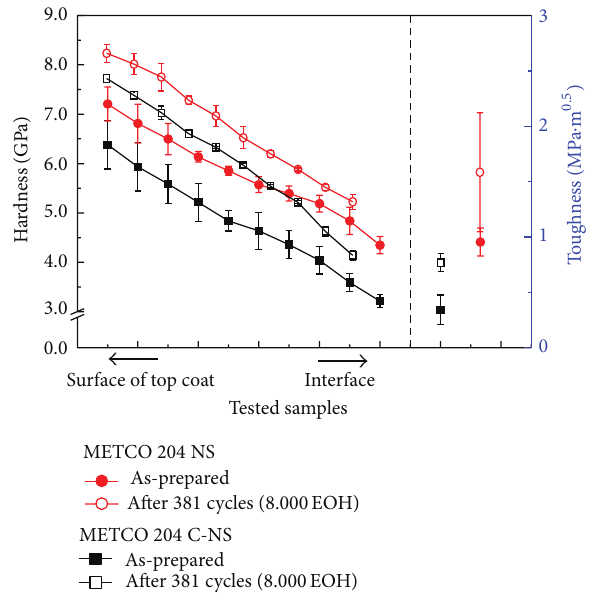
Figure 4: Hardness and fracture toughness values of TBCs before and after cyclic thermal exposure tests for 381 cycles. Indentation was conducted on the sectional surface with 3 and 30 N for hardness and fracture toughness,